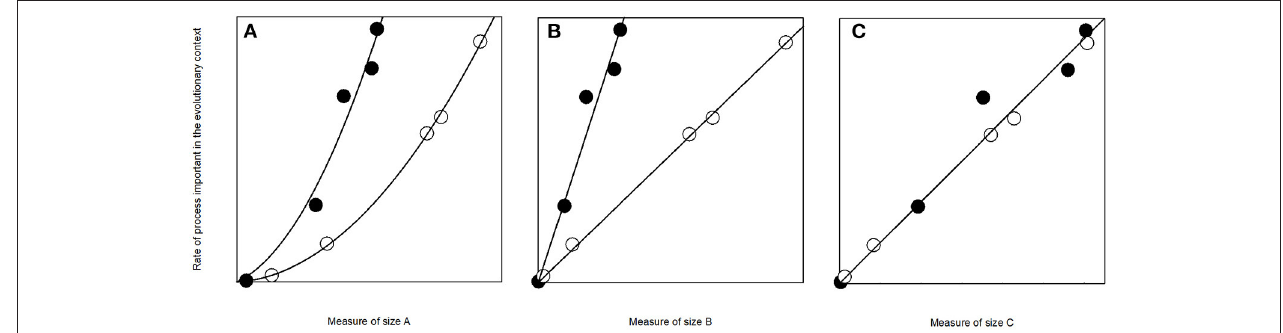
FIGURE 1 | Hypothetical demonstration on how the measure of size may influence our perception of important processes. The tree species represented with open and closed circles appear different when compared relative to measures of size A and B but not based on C. The process on the Y -axis could for example be transpiration, and measure of size A diameter, B basal area, and C cross-section mass, i.e., biomass per unit length of the trunk, at breast height (instead of more common biomass as that would require assumptions on height, taper, and branches). I computed the data assuming a three-fold wood density for the species represented with closed circles and added some random variation so that the dataset appears more realistic. Scientists normally pay enough attention on differences between dimension-based measures such as A and B. However, this article focuses on impacts of wood density on size and how results may change when studying wood density related structures and processes when using measures based only on dimensions ( A and B ) or those influenced also by wood density (C) . This is important as based on A and B a study could conclude that the species with higher wood density has higher transpiration. With more species with similar differences, a study based on measure A or B would conclude that increasing wood density increases transpiration, while a study based on C would claim that wood density does not influence transpiration.